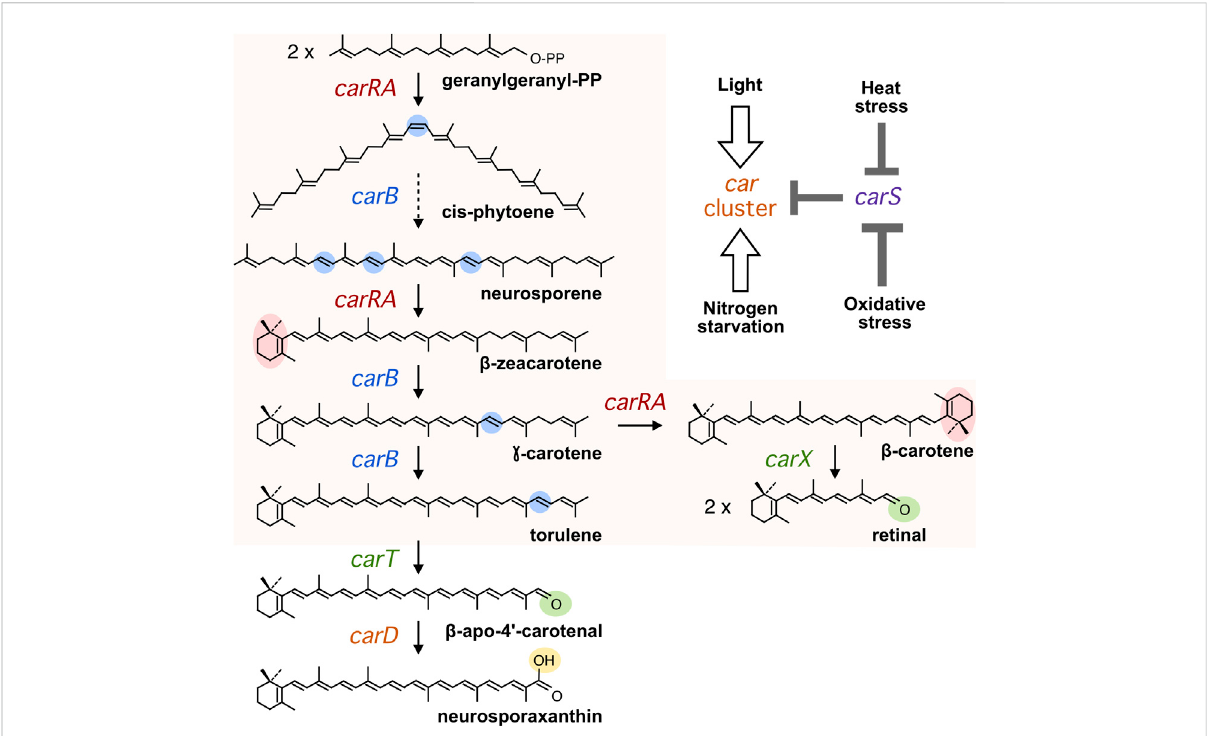
FIGURE 1 Carotenoid biosynthesis in Fusarium . Chemical modi fi cations in each step are highlighted in color. The dashed arrow summarizes three sequential desaturations. The car genes encoding the enzymes in charge of each reaction are indicated. The orange area indicates the steps in charge of the genes of the car cluster. In the top on the right, it is depicted a simpli fi ed model for the effects of the four inducing conditions mentioned in the text (White arrows indicate positive effects on transcription of the car genes and grey bars indicate negative effects on carS